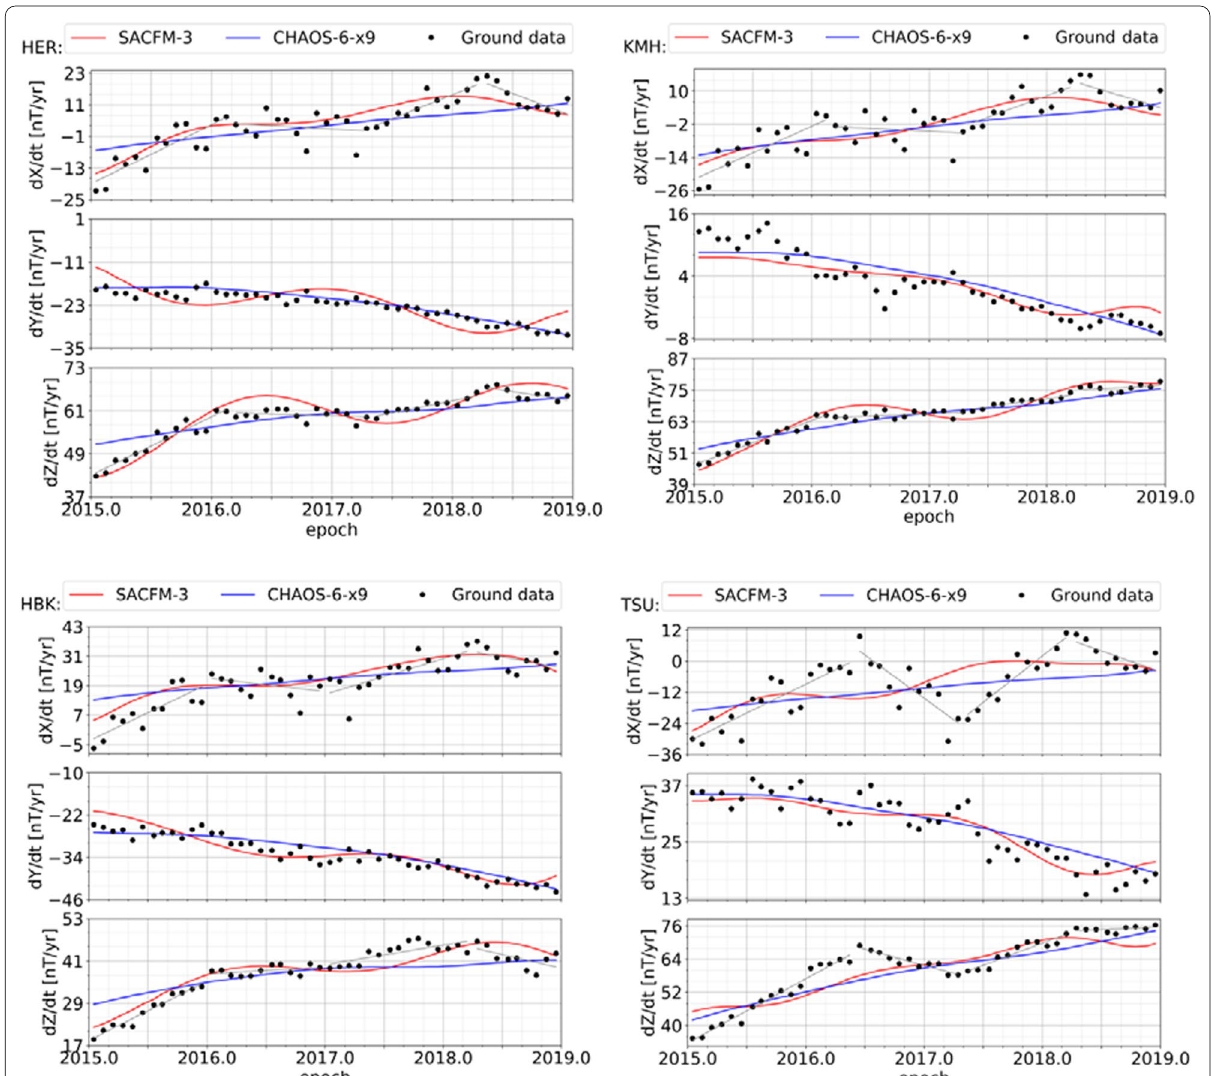
Fig. 4 The secular variation trend in X, Y and Z field components between 2015.0 and 2019.0 from the four INTERMAGNET observatories, HER, HBK, TSU and KMH (black dots), with the two models, CHAOS-6- abrupt changes of